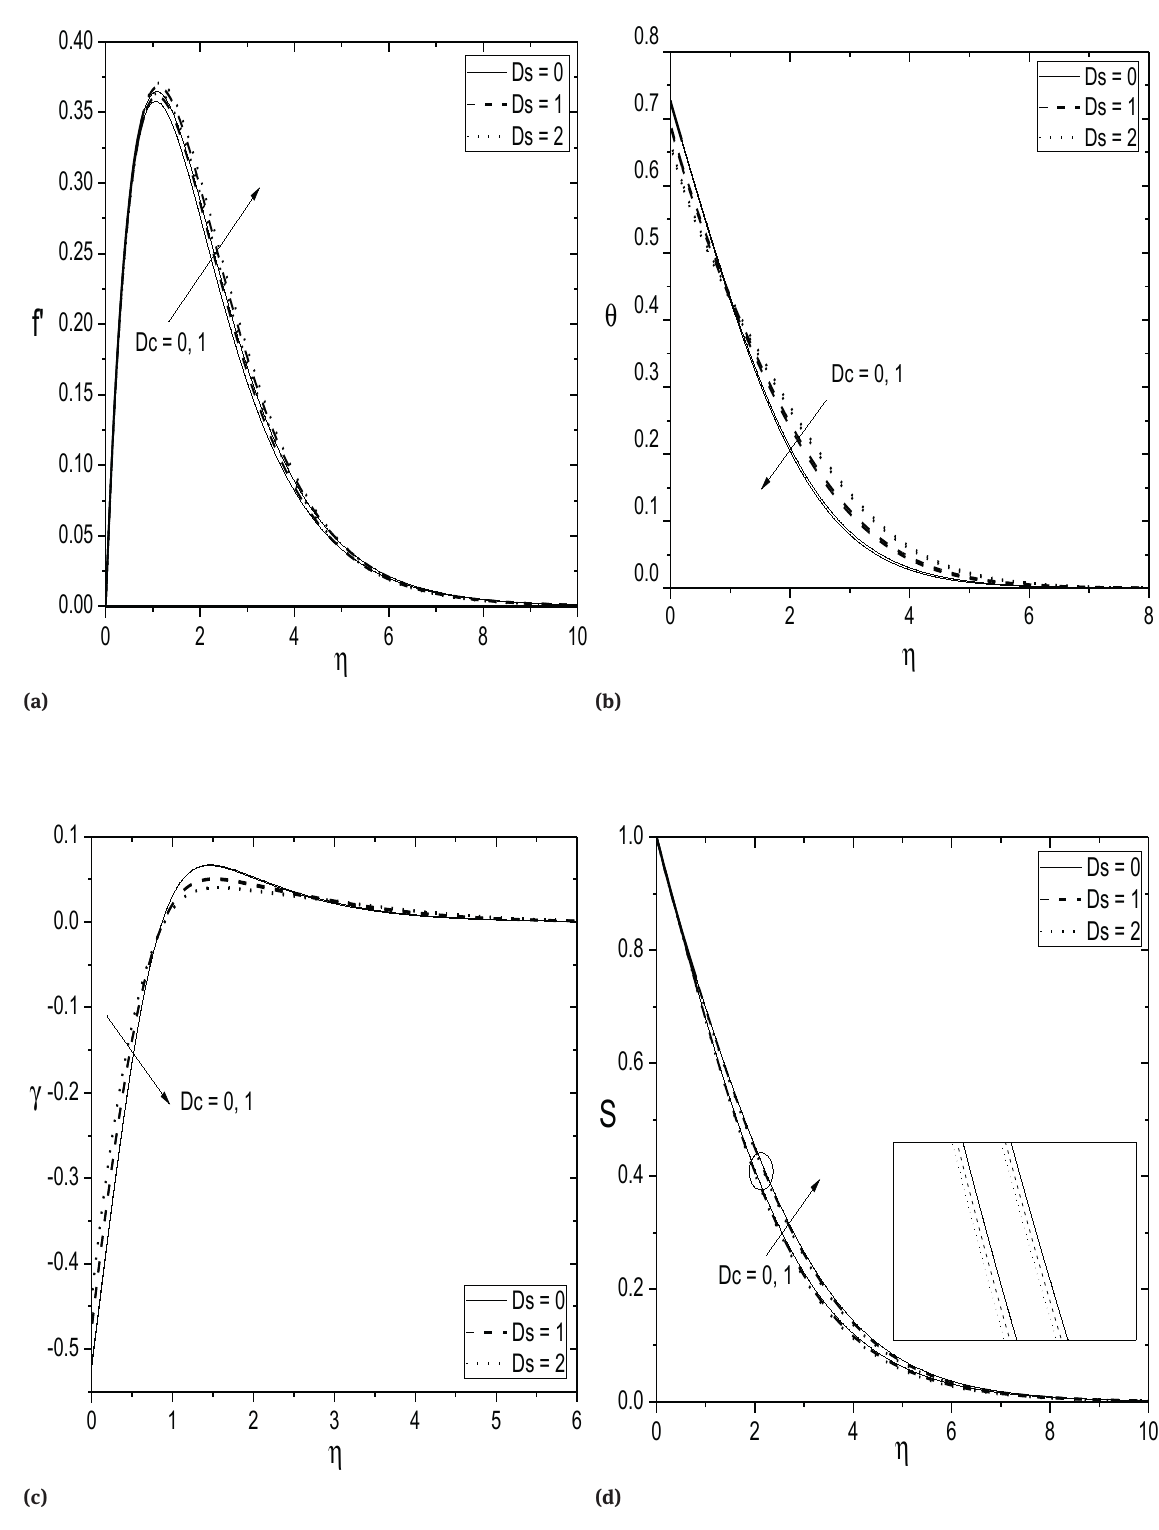
Fig. 6: Effect of Ds and Dc on (a) velocity, (b) temperature, (c) nanoparticle volume fraction, and (d) regular concentration for Fs = 0.5, Bi =